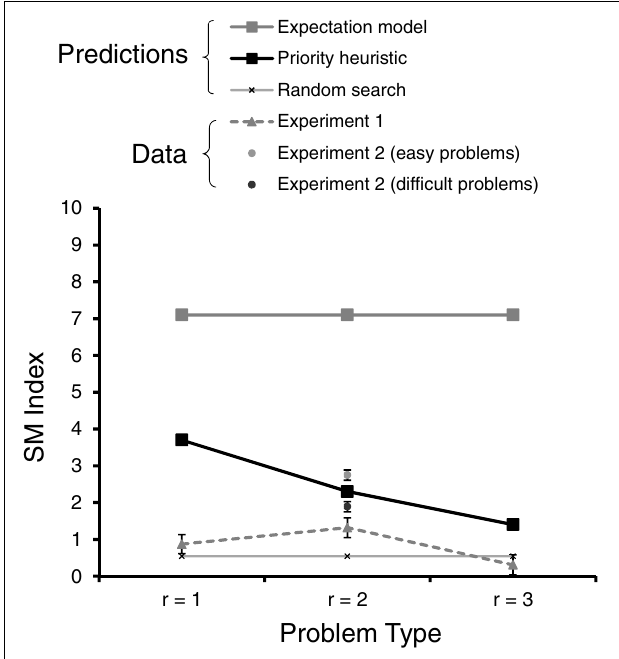
FIGURE 1 | Predicted and observed SM index (for reading and choice phases combined) in Experiments 1 and 2, separately for one-reason ( r = 1), two-reason ( r = 2), and three-reason ( r = 3) choices. The error bars represent standard errors of the